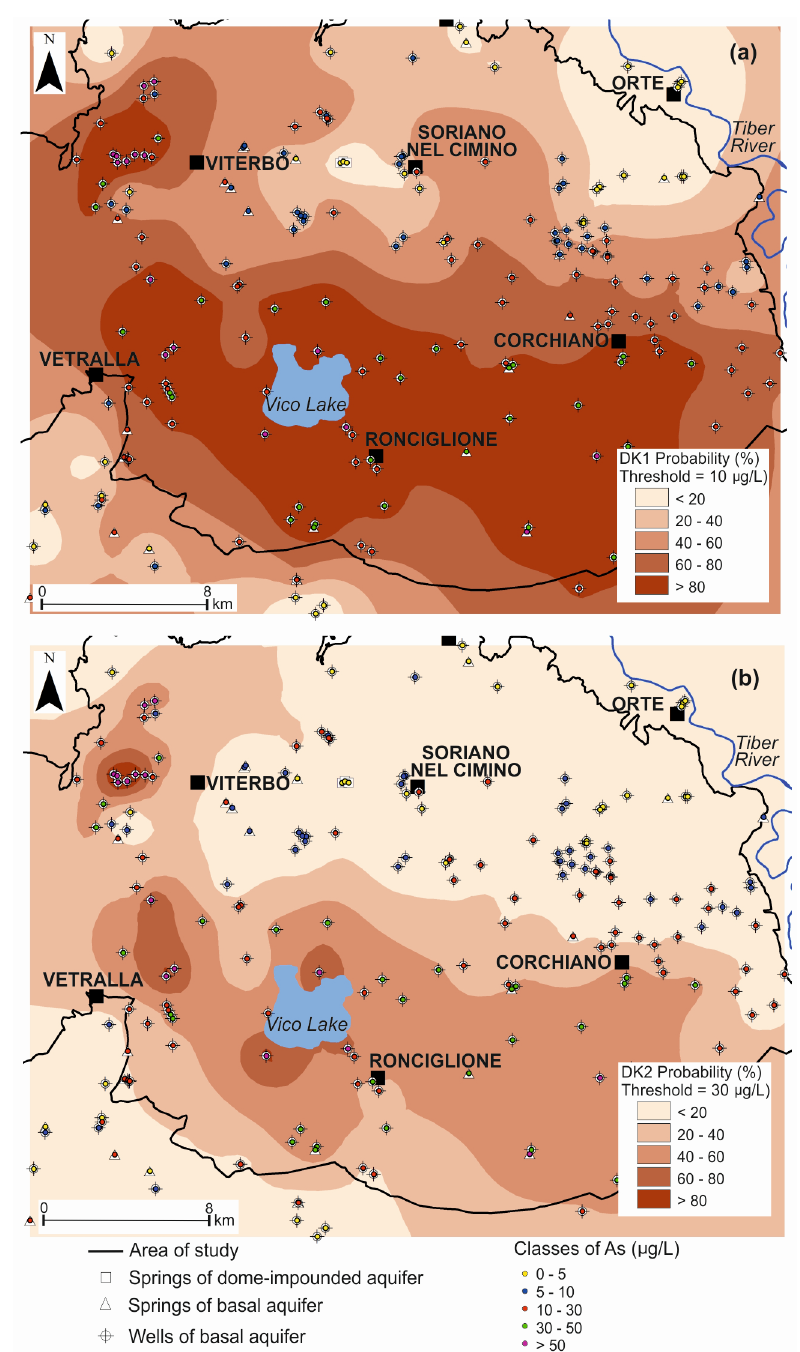
Figure 9. ( a ) Disjunctive Kriging (DK1) with threshold =10 µg/L; and ( b ) disjunctive Kriging (DK2) with threshold = 30